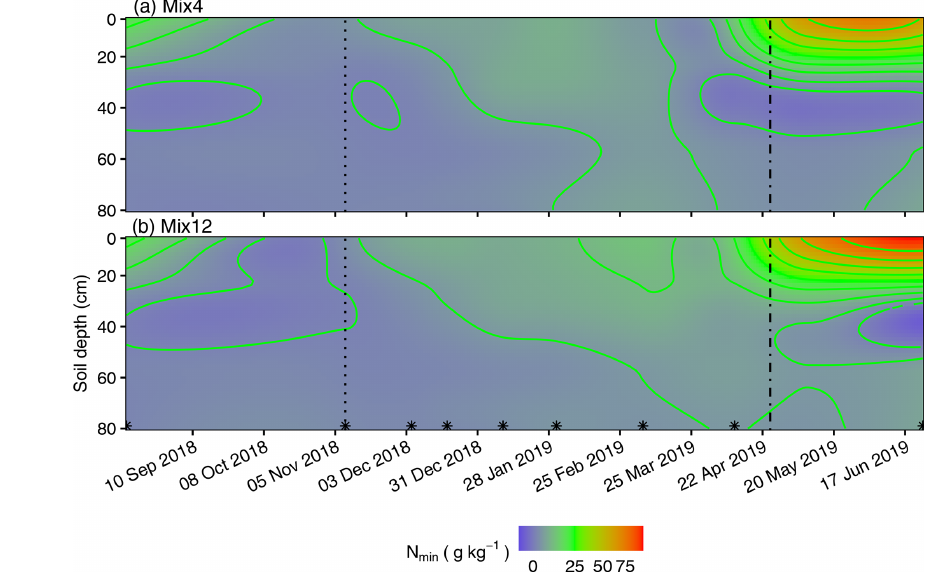
Figure 4. Spatiotemporal resolution of N min concentrations in soil spanning a 313d period under (a) Mix4 and (b) Mix12. The dotted lines indicate CC termination, dashed lines mark the seeding of maize following CCs or fallow and asterisks indicate sampling dates.